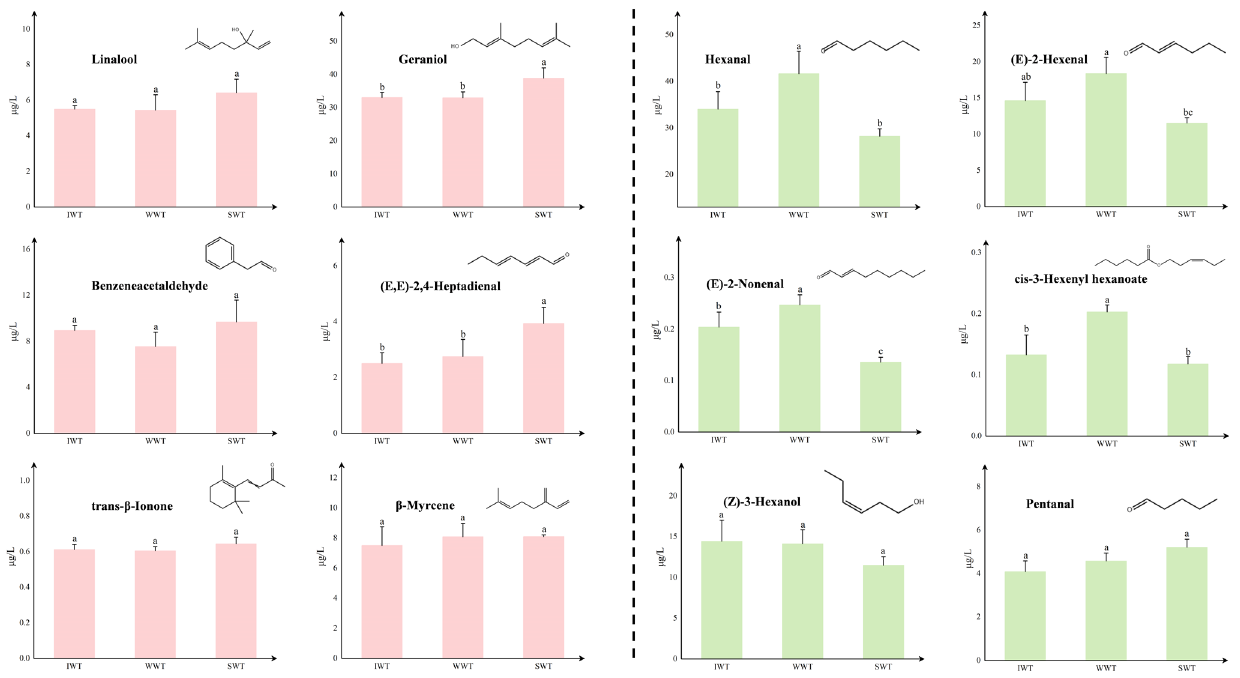
Figure 4. Differences in concentration of key odor-active compounds among white teas. On the left are odor-active compounds with floral odor, and on the right are odor-active compounds with green odor. Data are shown as the mean ± standard deviation ( n = 3). Different letters on the columns represent they have significant difference ( p < 0.05). (SWT: sunlight withering-treated white tea; WWT: withering tank withering-treated white tea; IWT: indoor withering-treated white tea).